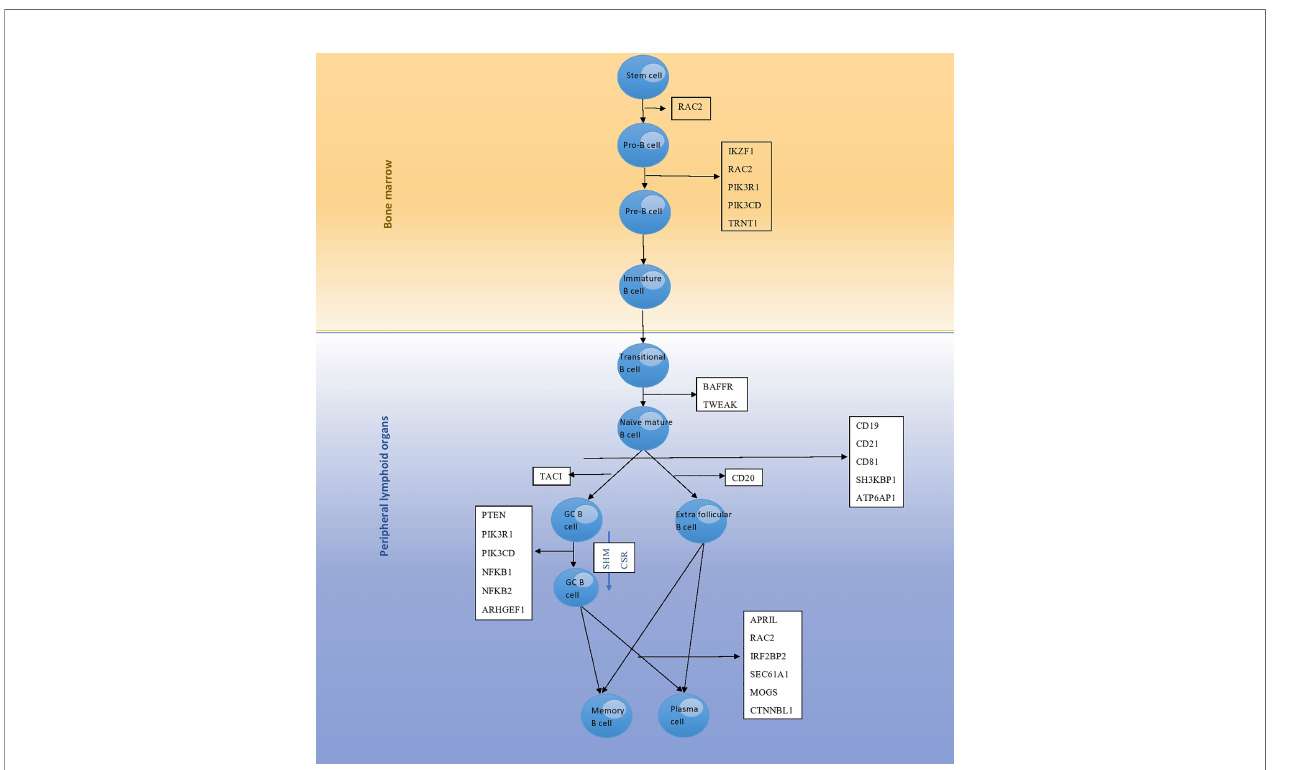
FIGURE 1 | The development pathway of B cells and genes involved in each stage; mutation of these genes leads to monogenic CVID. RAC2 encodes a protein that is involved in the differentiation of stem cells to pro-B cells, as well as pro-B cells to pre-B cells. Differentiation of pro-B cells to pre-B cells is further regulated by proteins encoded by the IKZF1 , PIK3R1 , PIK3CD and TRNT1 genes. BAFFR and TWEAK encode proteins involved in differentiation of transitional B cells to na ϊ ve mature B cells. Then, na ϊ ve mature B cells undergo selection and enter peripheral lymphoid tissues that is regulated by proteins encoded by the CD19 , CD21 , CD81 , SH3KBP1 and ATP6AP1 genes. TACI encodes a protein involved in conversion of na ϊ ve mature B cells to germinal center B cells. CD20 encodes a protein involved in conversion of na ϊ ve mature B cells to extra follicular B cells. Finally, plasma cell differentiation is regulated by proteins encoded by the APRIL , RAC2 , IRF2BP2 , SEC61A1 , MOGS and CTNNBL1